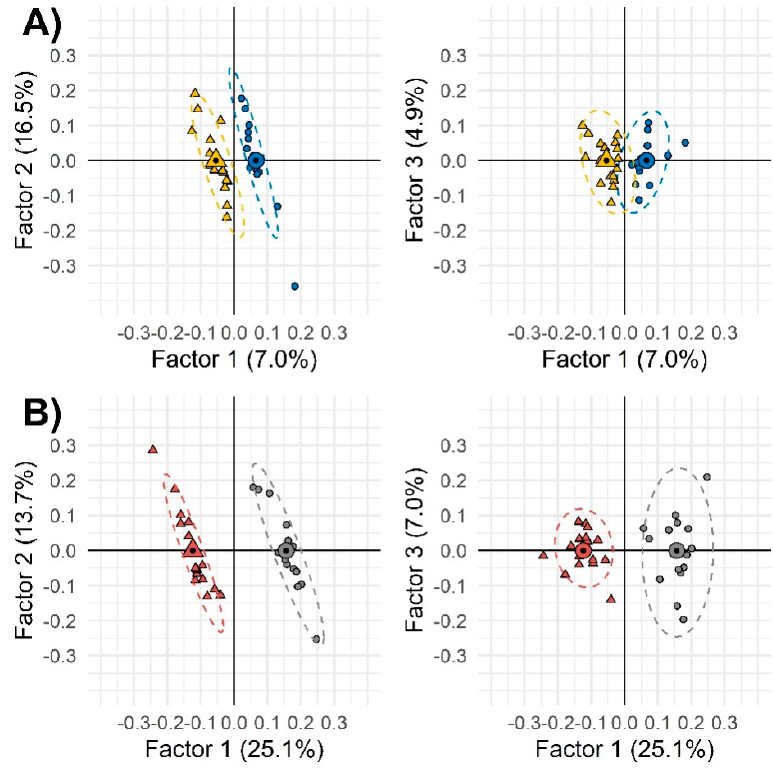
Figure 2. Two-by-two orthogonal partial least square-discriminant analysis (OPLS-DA) of the combined untargeted and targeted UT peak-region features filtered by Fisher ratio from the whole samples’ set. Group 1 (less sedentary group) and Group 2 (more sedentary group) were depicted as circles and triangles, respectively. Di ff erent colors were used to indicate males (panel ( A ), blue and yellow) and females (panel ( B ), gray and dark red). Small and large (with a black spot) symbols represent individual and mean values, respectively.